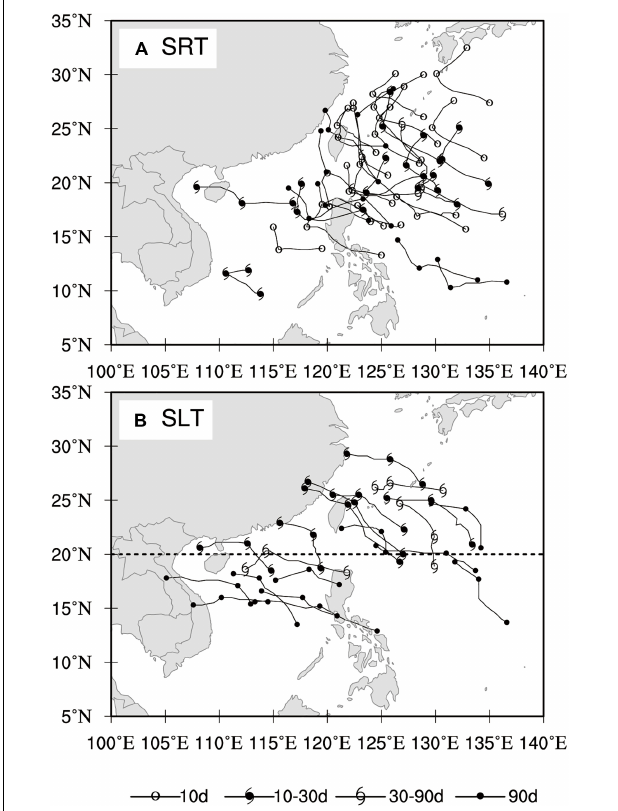
FIGURE 1 | The track segments of (A) SRT and (B) SLT cases around the turning time during the period of 2000–2019. Here each track segment is connected by three points which representing the TC positions before/at/after turning time, respectively. The dominant waves related to each sudden turning process are shown with the different symbols.